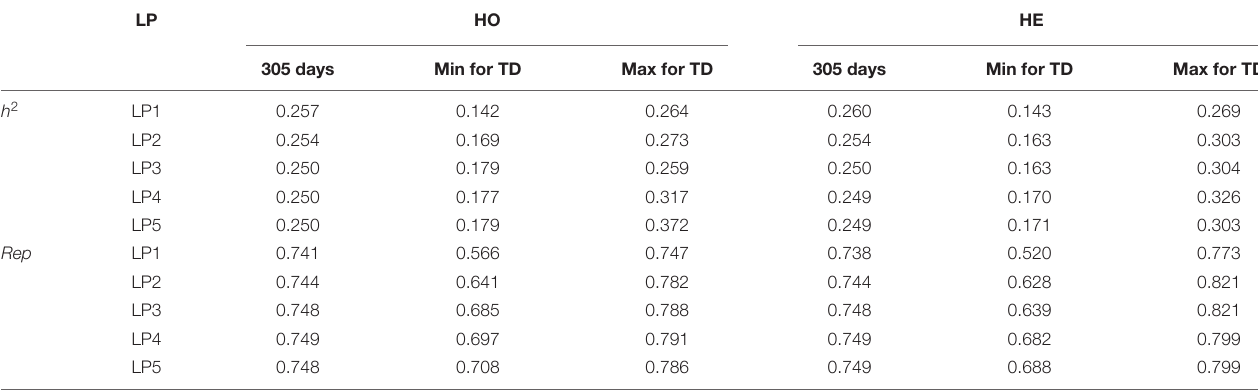
TABLE 4 | Heritabilities ( h 2 ) and Repeatabilities ( Rep ) for 305 days milk yield and minimal (Min) and maximal (Max) h 2 and Rep for TD in different LP considering homogeneous (HO) and heterogeneous (HE) residual variances.